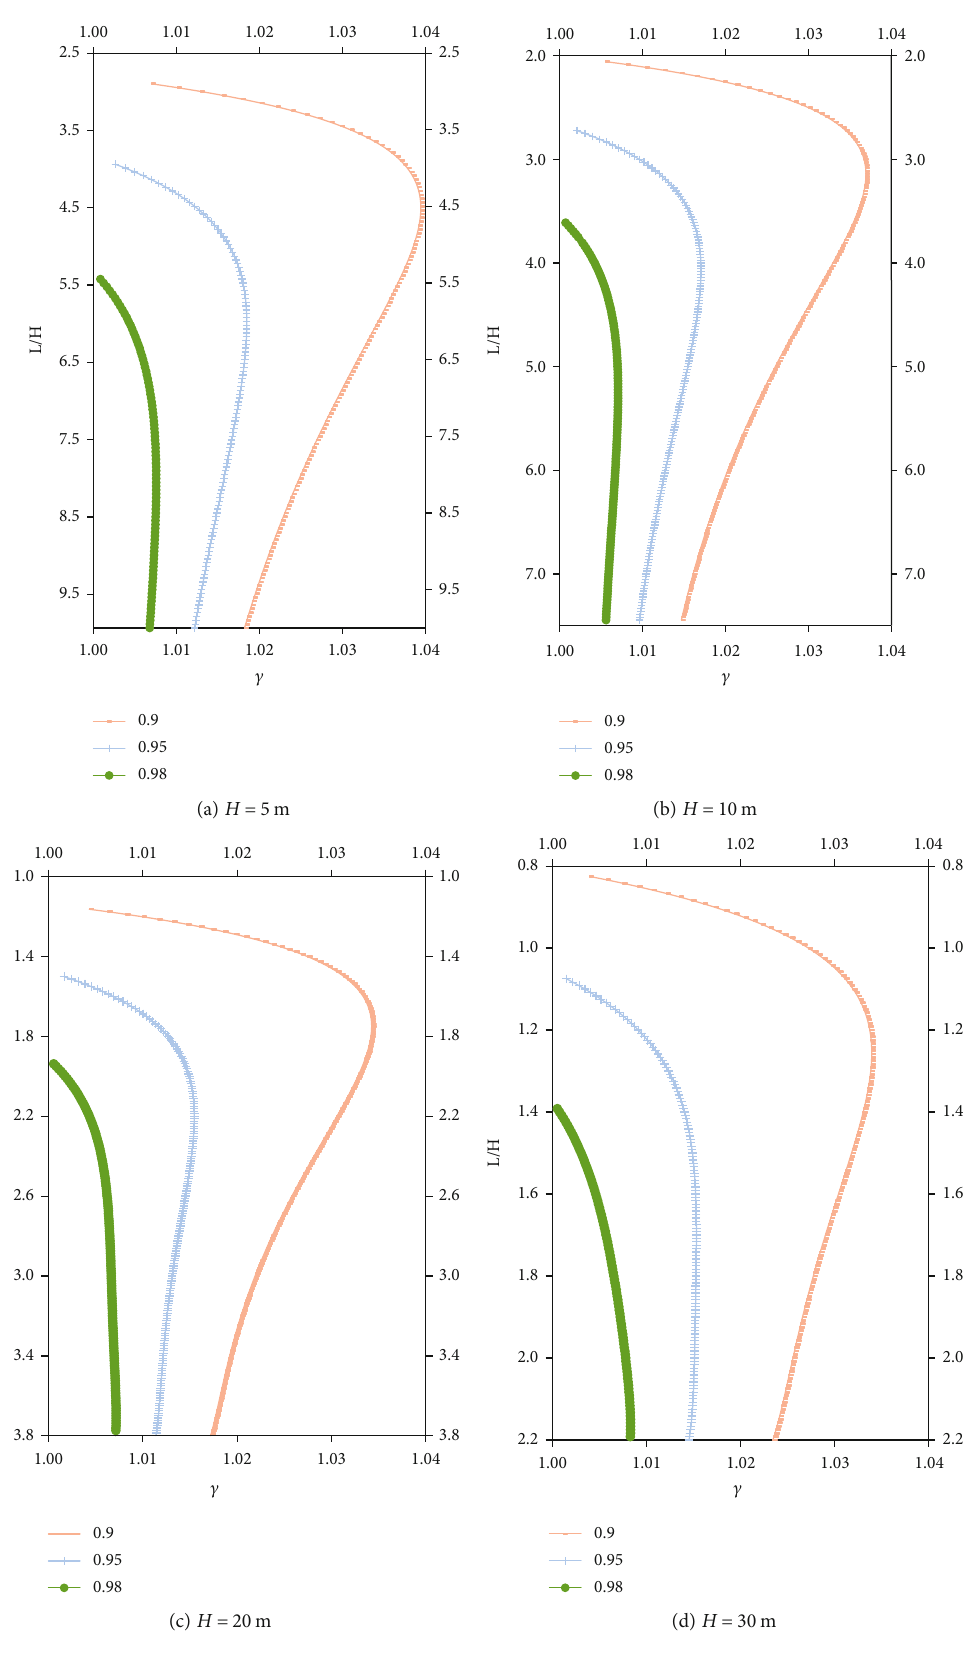
Figure 2: Change curve of increment coe ffi cient of pile side friction resistance with L / H (ratio of pile length and excavation